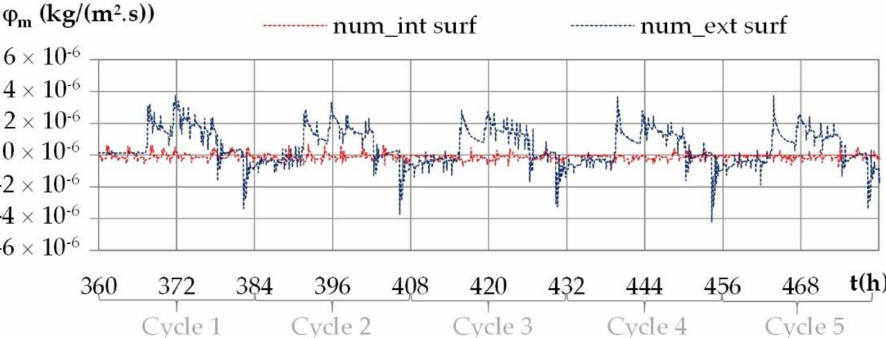
Figure 20. Numerical moisture fluxes on the interior and exterior surfaces during the daily cycles for the climate of